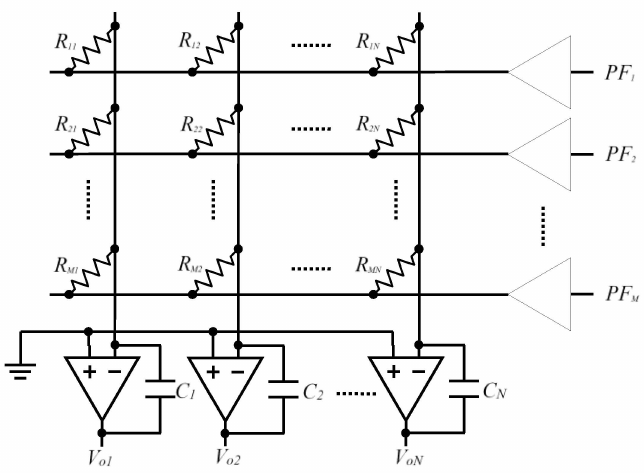
Figure 1. Schematic proposed in [13] for reading of a resistive array.